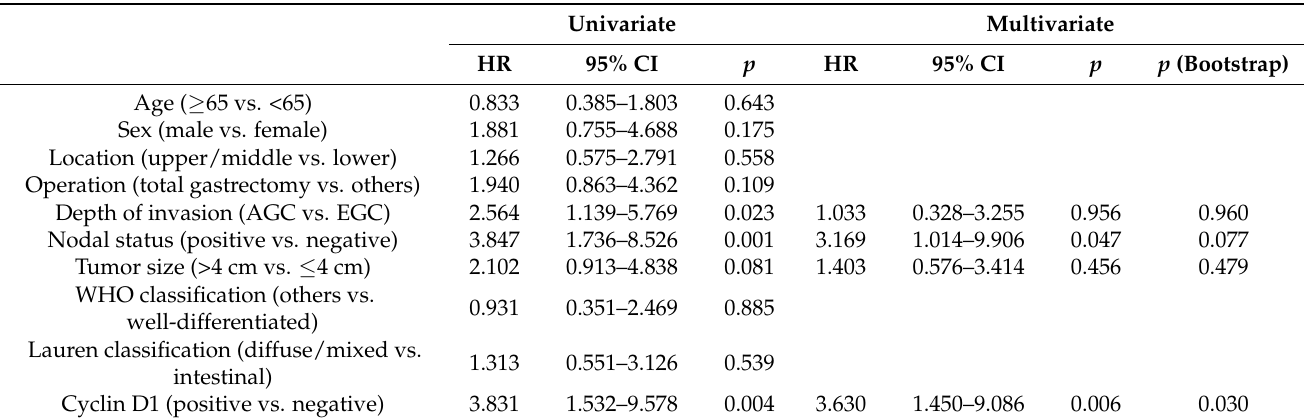
Figure 7. Forest plot for subgroup analyses of overall survival by cyclin D1 positivity in propensity score-matched cohort. Table 3. Cox regression for overall survival after